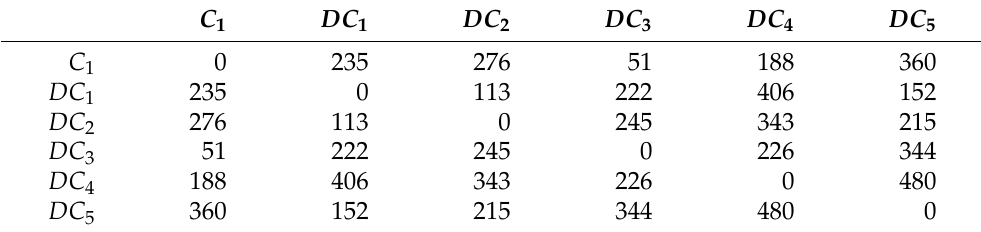
Table 6. Temporal distance between nodes [minute], referring to the first supplier.